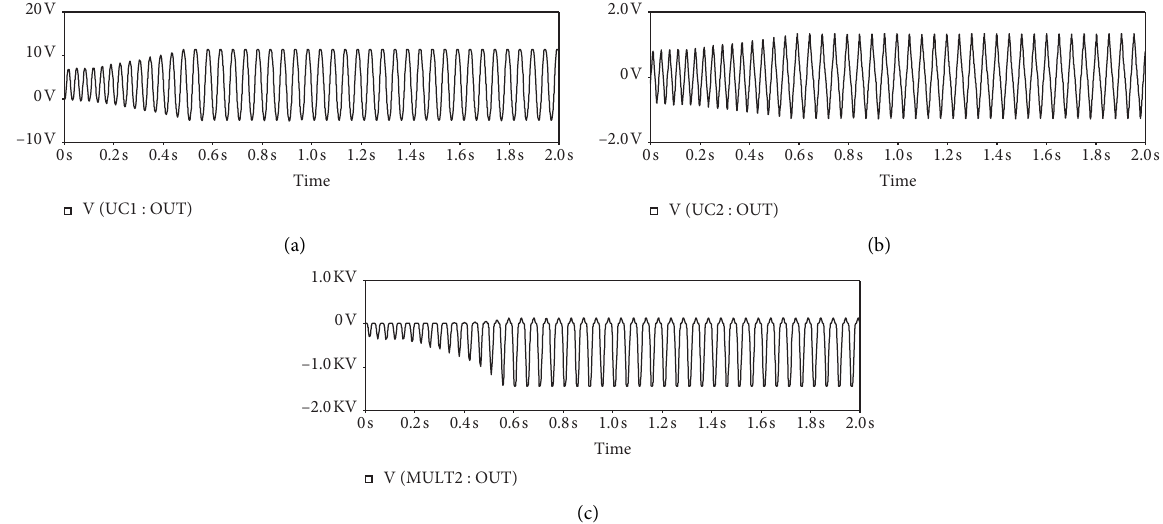
, (b) amplifier with capacitor C 1 � 12V , R � 5 K Ω ,R cc 4